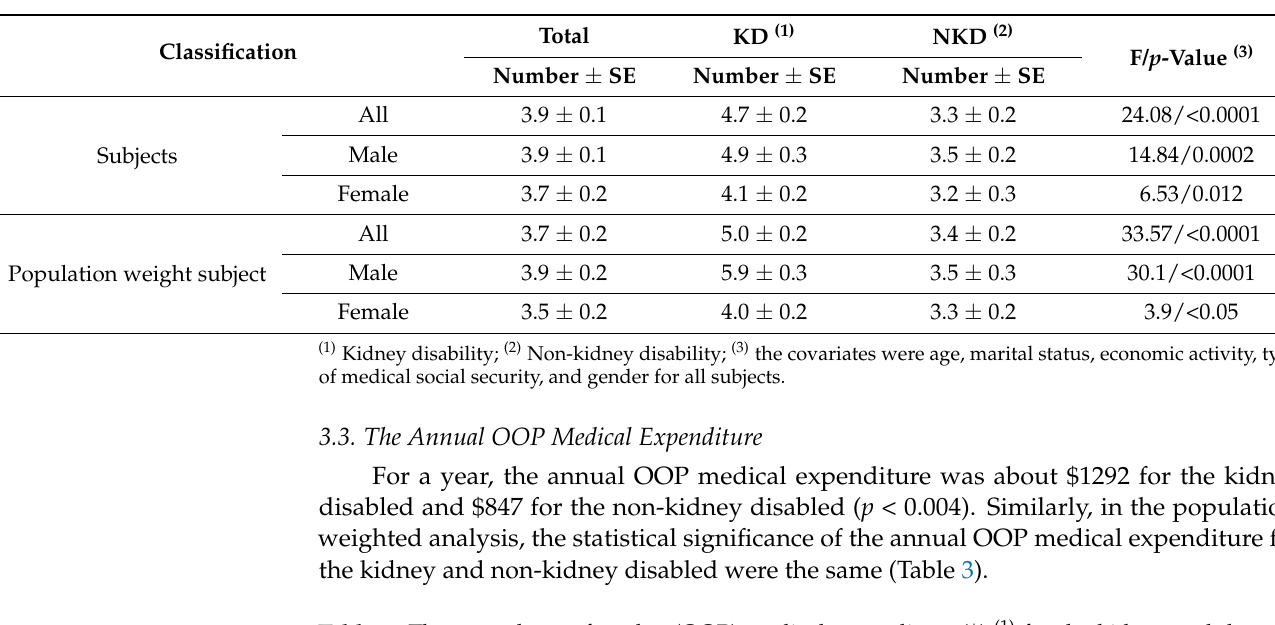
Table 3. The annual out-of-pocket (OOP) medical expenditure ($) (1) for the kidney and the non- kidney disabled by ANCOVA in five-year KHP pooled